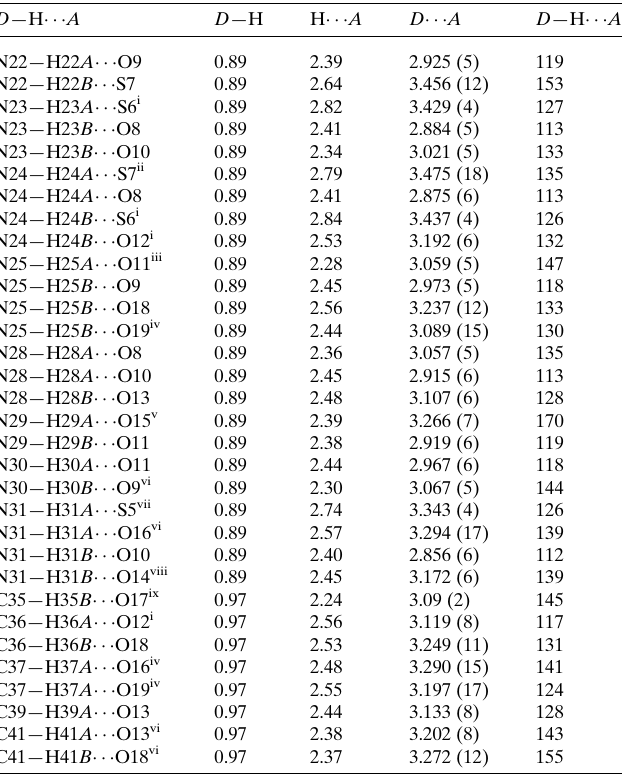
Table 3 Hydrogen-bond geometry (A˚ , (cid:5) ) for